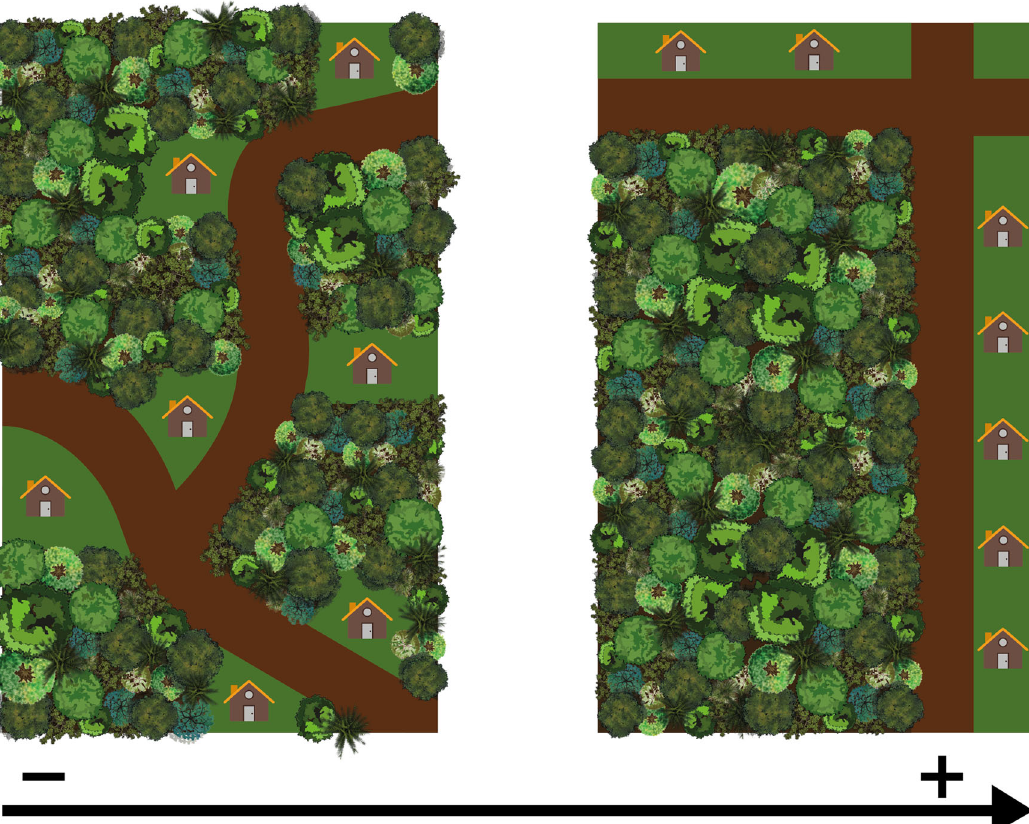
Fig. 4 Landscape structure and human health outcomes. Graph theory shows a landscape con fi guration that presents less pollution ( – ) and consequently is more bene fi cial to human health and more pollution ( + ) and is detrimental to human health considering fi res-related diseases and